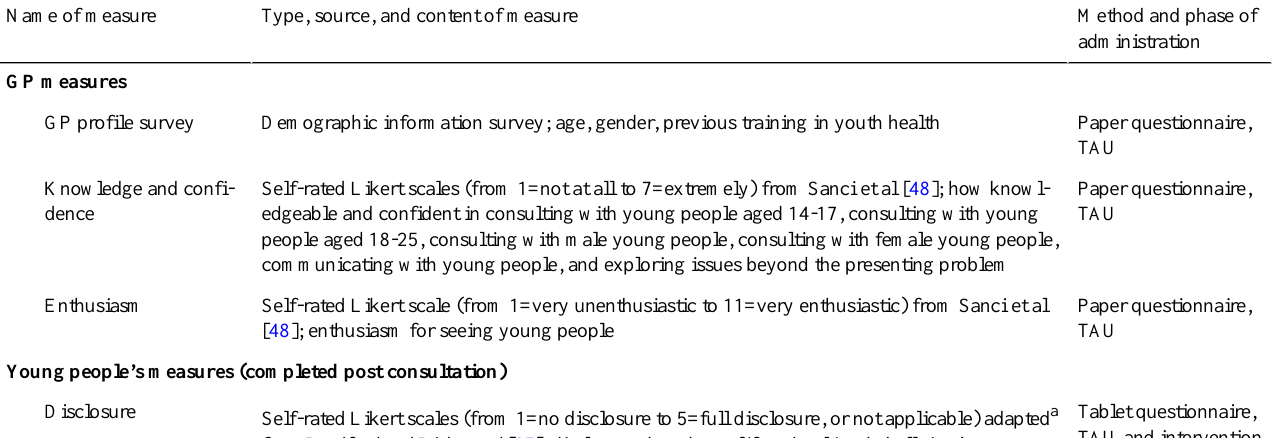
Method and phase of administrationType, source, and content of measureName of measure